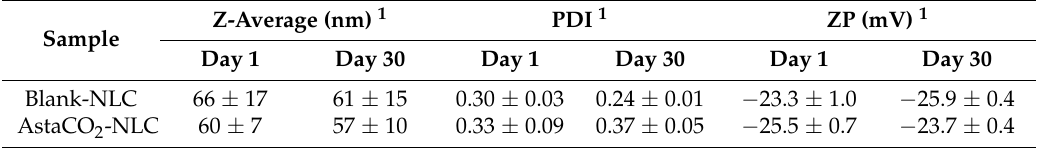
Table 1. Physicochemical NLC parameters: average particle size (number-based distribution Z-average), polydispersity index (PDI), and zeta potential (ZP) after synthesis (Day 1) and after 1 month (Day 30).